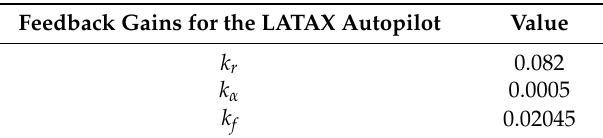
Table 3. Feedback gains.